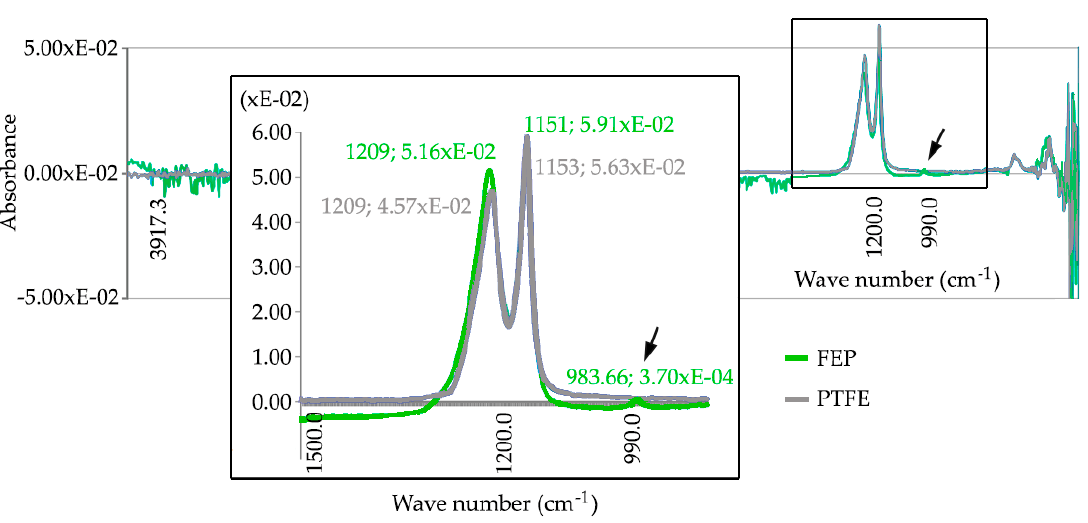
Table 4. Parameters selection tests for the Nd:YAG (CW) 2200W laser stripping of non-stick coatings (grey: final conditions selection for PTFE; green: final condition selection for FEP).